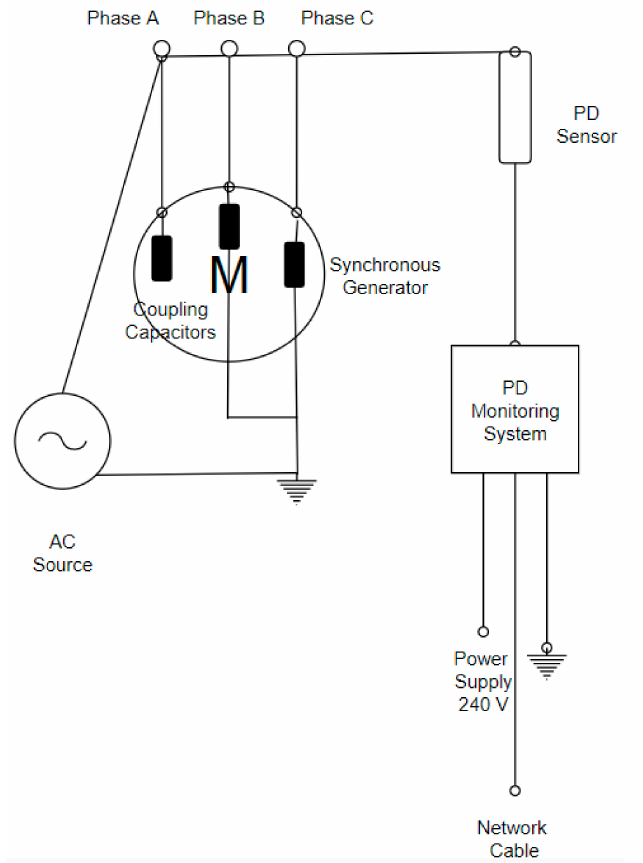
Figure 5. Online PD Measurement Arrangement.